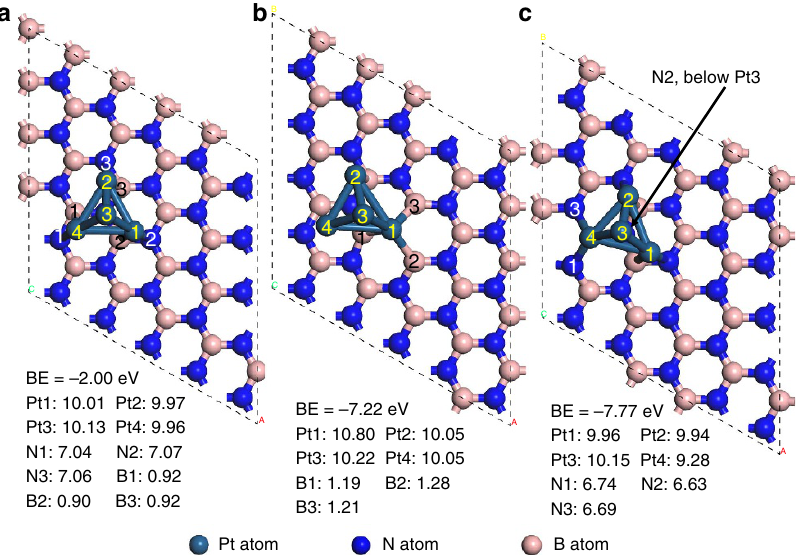
Figure 5 | Optimized structures and valence electrons of pyramidal Pt 4 cluster on h- BNNS. ( a ) Pt 4 cluster on clean, vacancy-free h -BNNS. ( b ) Pt 4 cluster h -BNNS with Nv. ( c ) Pt 4 cluster on h -BNNS with